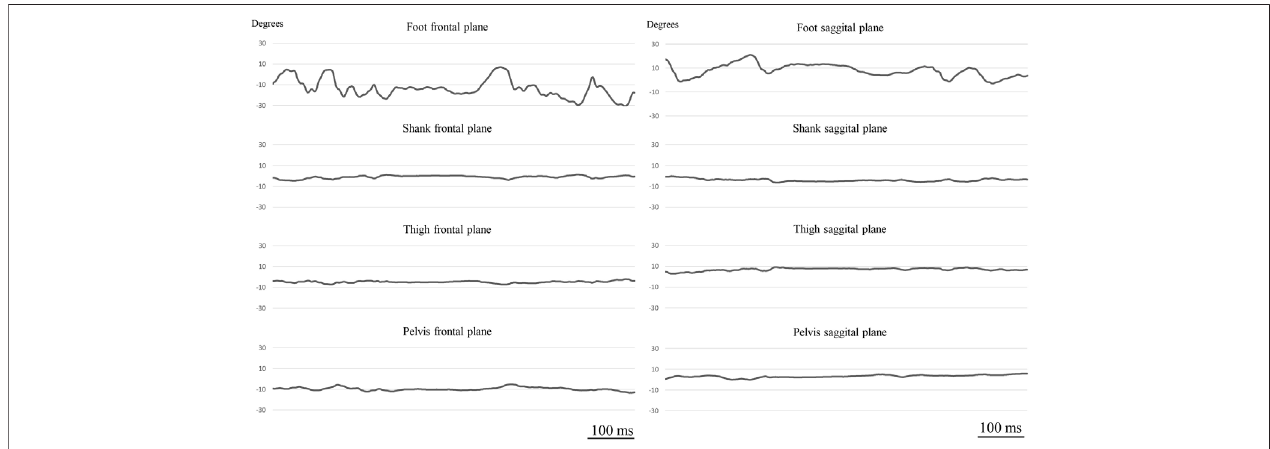
FIGURE 2 | A representation of segmental (foot, shank, thigh, pelvis) orientation angle — time curve (sampling frequency: 100 Hz) obtained in frontal and sagittal planes during balancing on the Togu ® Jumper ® .